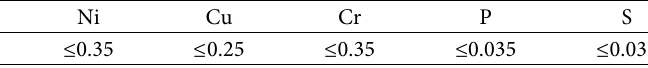
Table 1: Chemical composition of the 60Si2Mn plate (mass fraction, %).